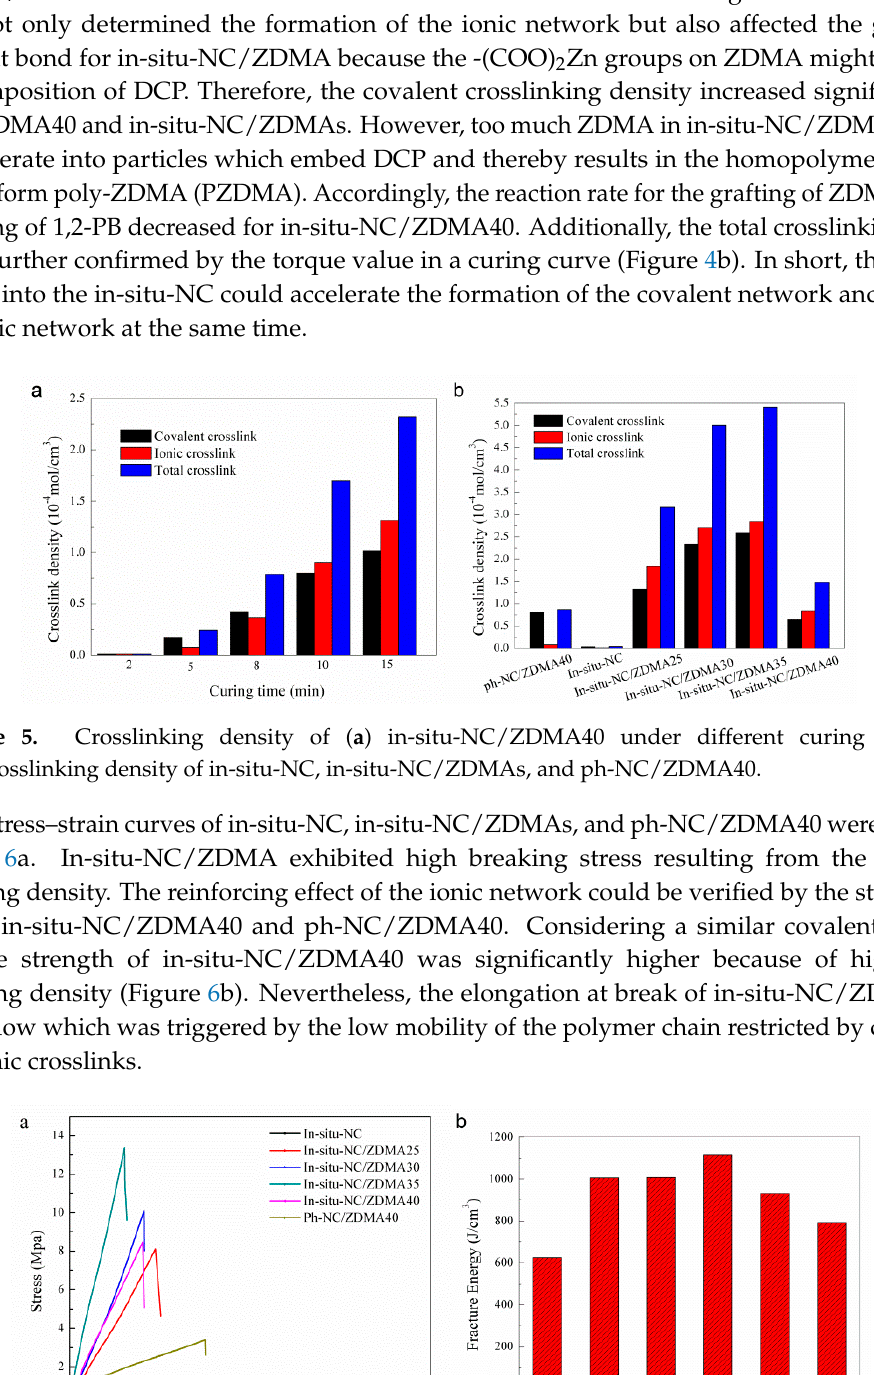
Figure 6. ( a ) Stress–strain curves of and ( b ) fracture energy of in-situ-NC, in-situ-NC/ZDMAs, and ph-NC/ZDMA40.